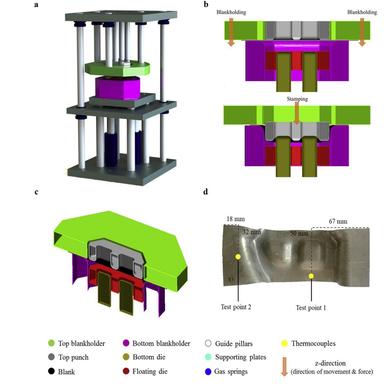
(a) The structure of the tool assembly; (b) The schematic diagram of the forming process; (c) The sectional view of the FE model; and (d) A wing stiffener component with the thermocouple locations.